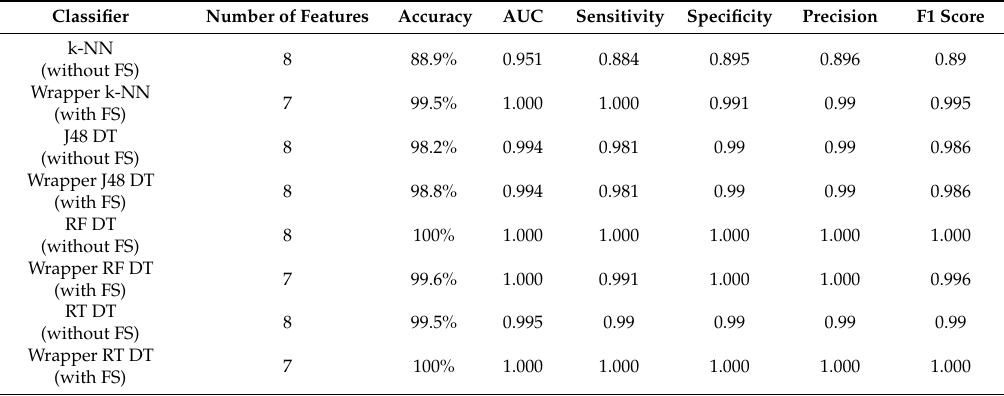
Table 4. The classification results before and after the feature selection results using the random search method for the MIAS